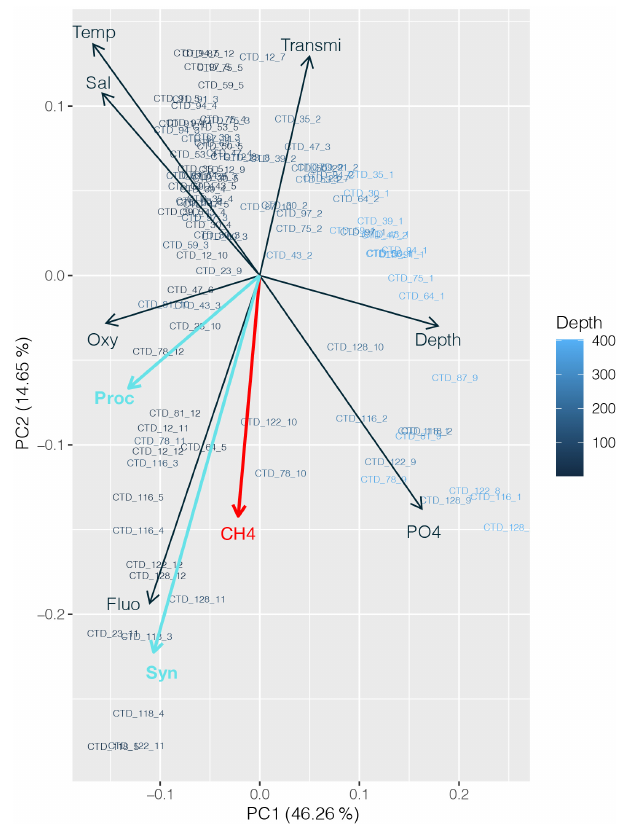
Figure 9. Principal component analysis (PCA) between dissolved CH 4 concentrations (red), Prochlorococcus and Synechococcus abundances (light blue), and other physicochemical parameters (nu- trients, depth, fluorescence, temperature, salinity and turbidity). Numbers on the x and y axes indicate the factor loadings of each variable of each principal component (PC). The percentages show the explained variability in the dataset by each